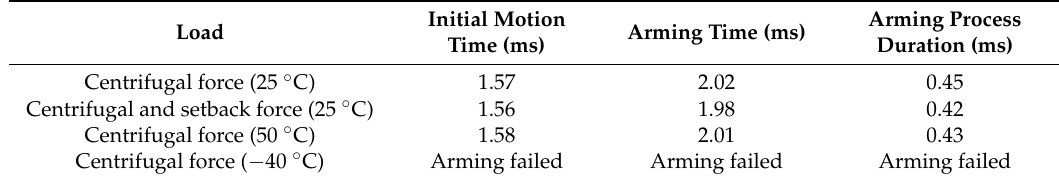
Figure 7. The simulation results of the micro S & A module under different rotary speeds. ( a ) 31,000 rpm; ( b ) 35,000 rpm; ( c ) 45,000 rpm.